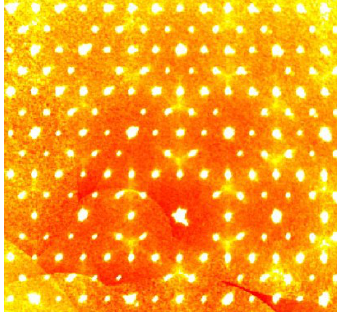
Figure 1. Reconstructed image of (hk2) layers of Fe 0.43 Mo 2.56 SbO 9. 5crystal.